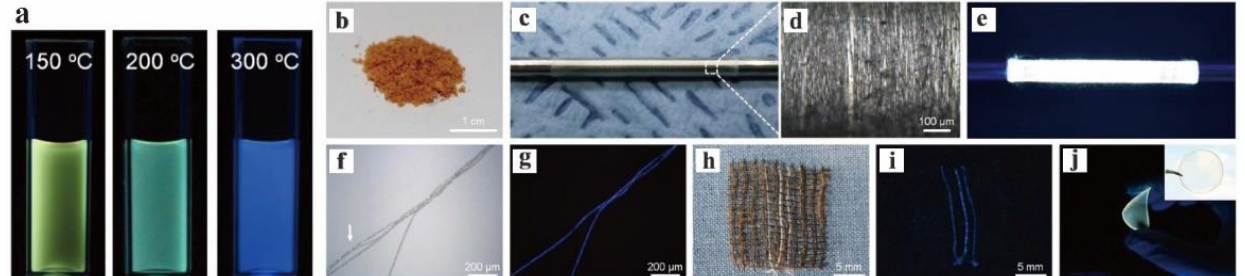
Figure 15. ( a ) Photographs of GQDs dispersions prepared at 150, 200, and 300 ◦ C (excited at 365 nm). ( b ) Photos of freeze-dried GQD powder; the images of long GQD fibers were taken at ( c ) low magnification and ( d ) high magnification. ( e ) GQDs fibers emit strong yellow light excited at 365 nm. ( f , g ) Optical microscopic images of blue GQD/PAA composite fibers and PAA fibers under ( f ) bright-field conditions and ( g ) ultraviolet irradiation. ( h ) Photographs of three GQD yarns woven from commercial cotton fabrics under white and ( i ) ultraviolet light. ( j ) Photos of yellow GQD/PAA composite membrane excited at 365 nm and under white light (illustration). Reprinted with permission from [92]. Copyright 2015, Springer